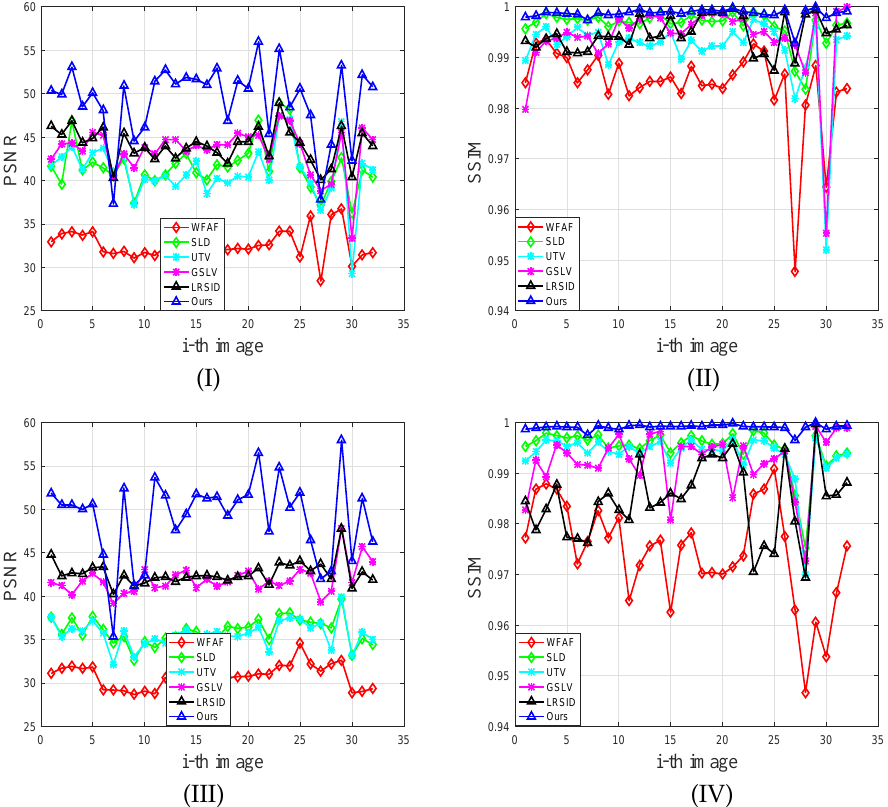
Figure 6. The PSNR and SSIM performance on 32 images for the stripes (Per, 100, 0.6) and (NonPer, 50, 0.2). The x-axis represents each image and the quantitative results are shown in the y-axis. (I) and (II) are the PSNR and SSIM results for the stripes (Per, 100, 0.6), respectively. (III) and (IV), respectively, represent the PSNR and SSIM performance of the stripes (NonPer, 50,